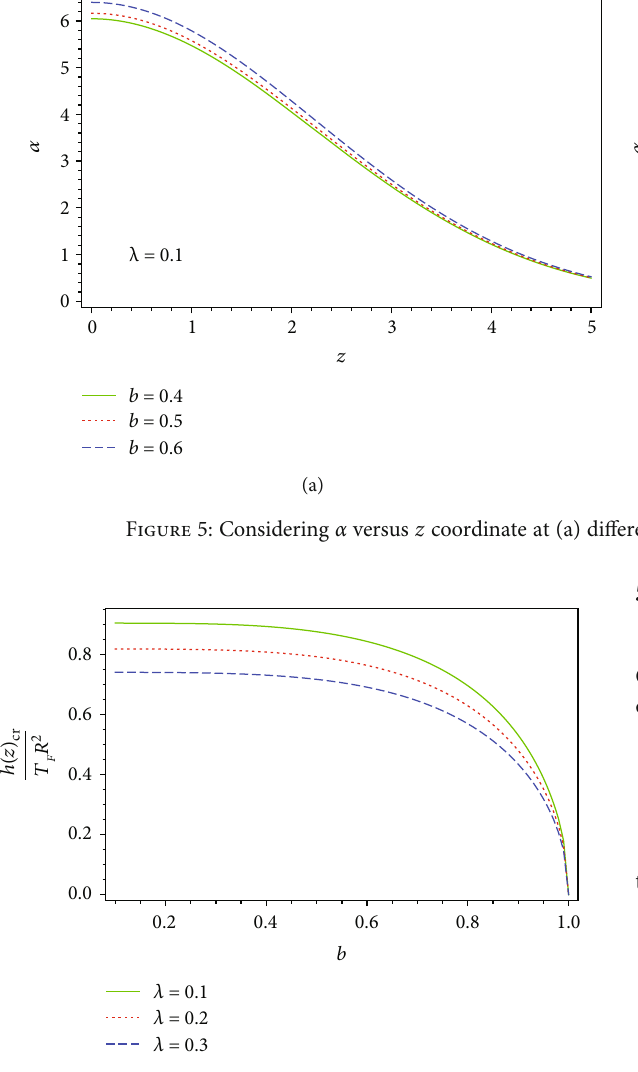
Figure 6: Considering behaviour of the critical fi eld versus